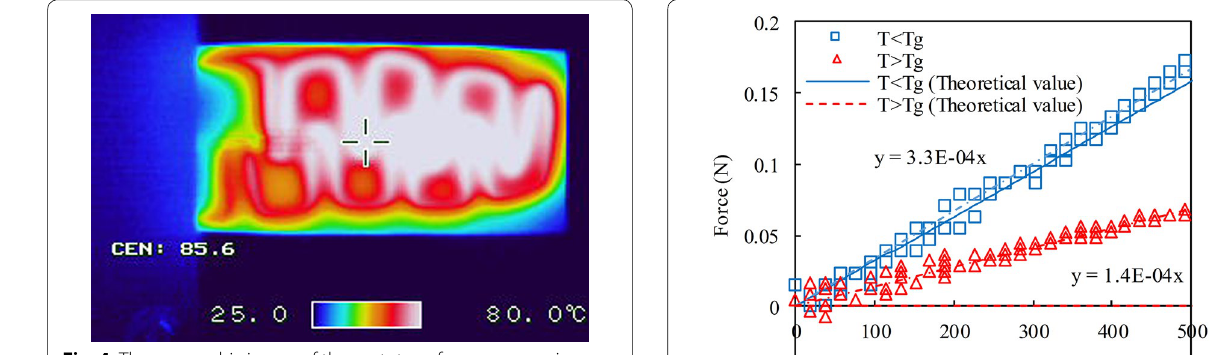
Fig. 4 Thermographic image of the prototype force sensor using an SMP sheet heated above T g